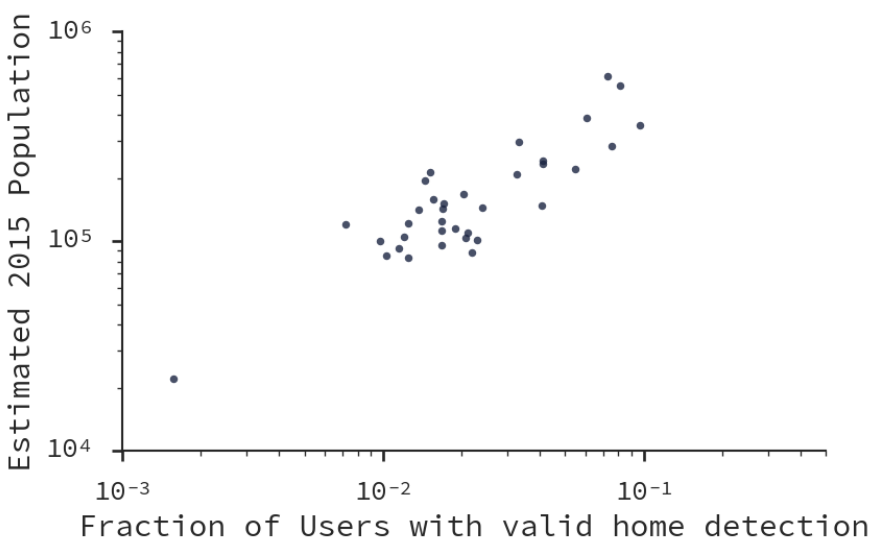
Figure 11. Scatterplot of the distribution of detected home locations and the 2015 estimated population for municipalities in Santiago. Both axis use a log-scale to account for the inequalities in population distribution. The non-scaled values show a Pearson correlation coefficient of r = 0.84 ( p < 0.001).